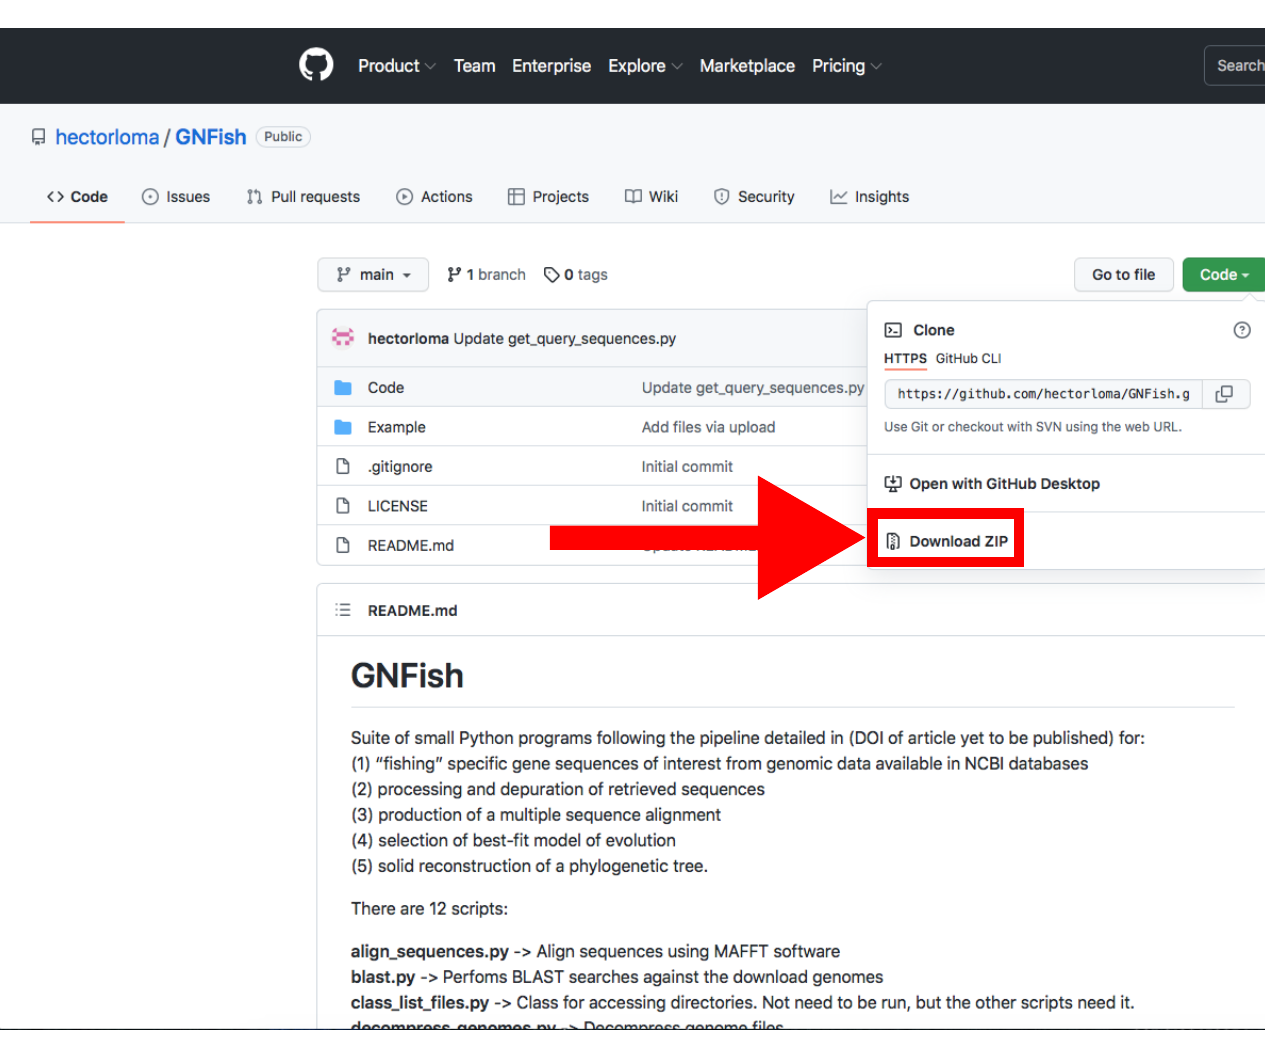
Figure 2. GitHub web server where the GNFish package is stored. The red arrow indicates the button for downloading. The Code button appears in green (top right). Accessed on 27 January 2022.